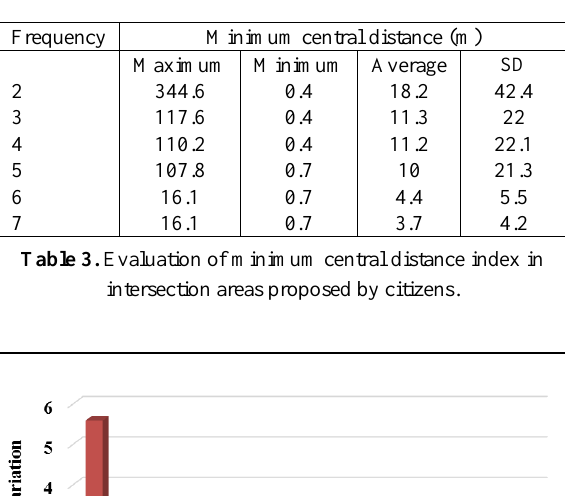
Figure 6. The frequency of citizen-proposed areas.